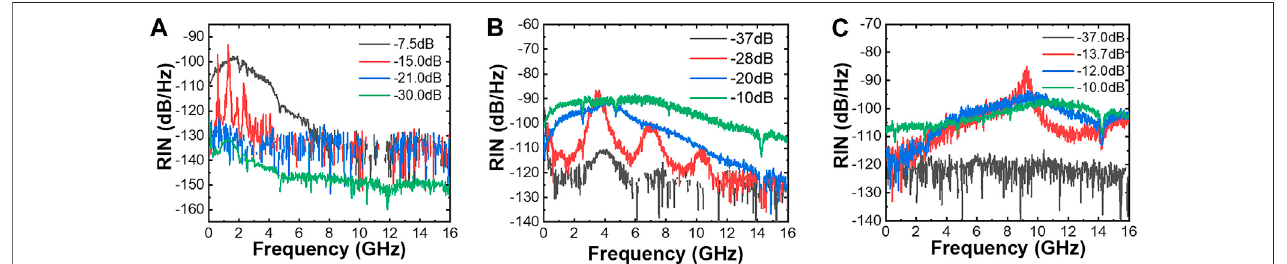
FIGURE 5 | The evolution of RIN of (A) the QD FP laser; (B) QW FP laser; and (C) QW DFB laser.